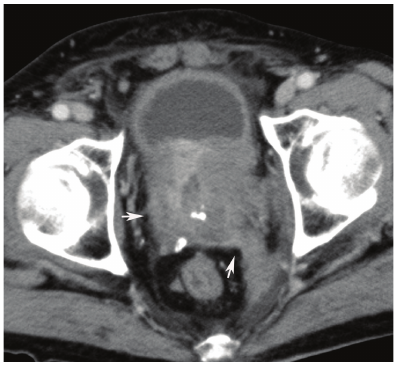
Figure 1: Contrast-enhanced CT demonstrated a large heteroge- neous mass (arrow).